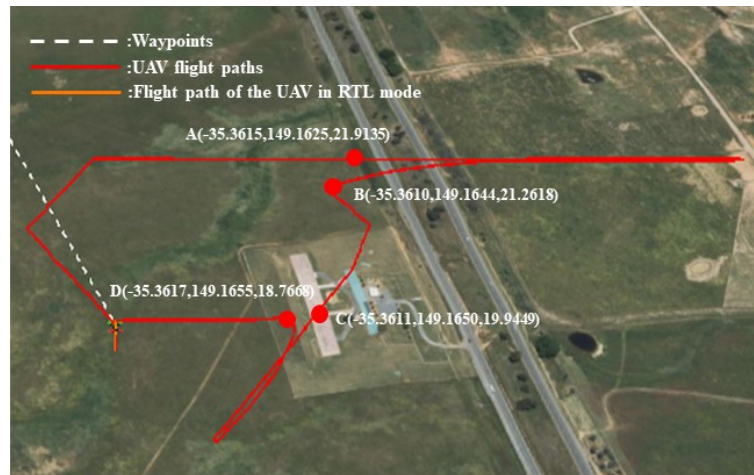
Figure 9. The fl ight trajectory of the UAV in the state of GPS failure. Figure 9. The flight trajectory of the UAV in the state of GPS